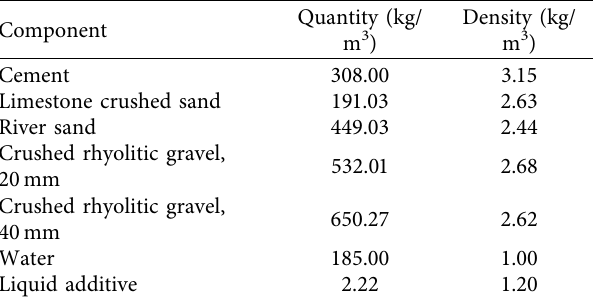
Table 2: Characteristics of the stage 1 aggregates.